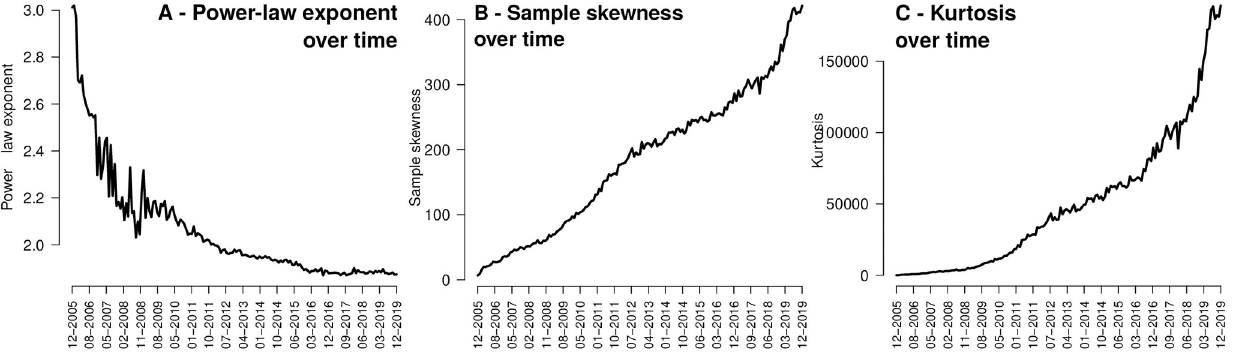
Fig 3. The distribution of user attention (i.e. number of links per active domain) in Reddit, over domains, is getting increasingly more skewed over time towards the popular domains: The rich are getting richer . (A) we fit a power-law distribution and we plot the exponent of the power-law distribution over time; it shows an decreasing trend over time (i.e. higher inequality). (B) and (C) we compute the sample skewness and kurtosis respectively; both show a upwards trend over time.